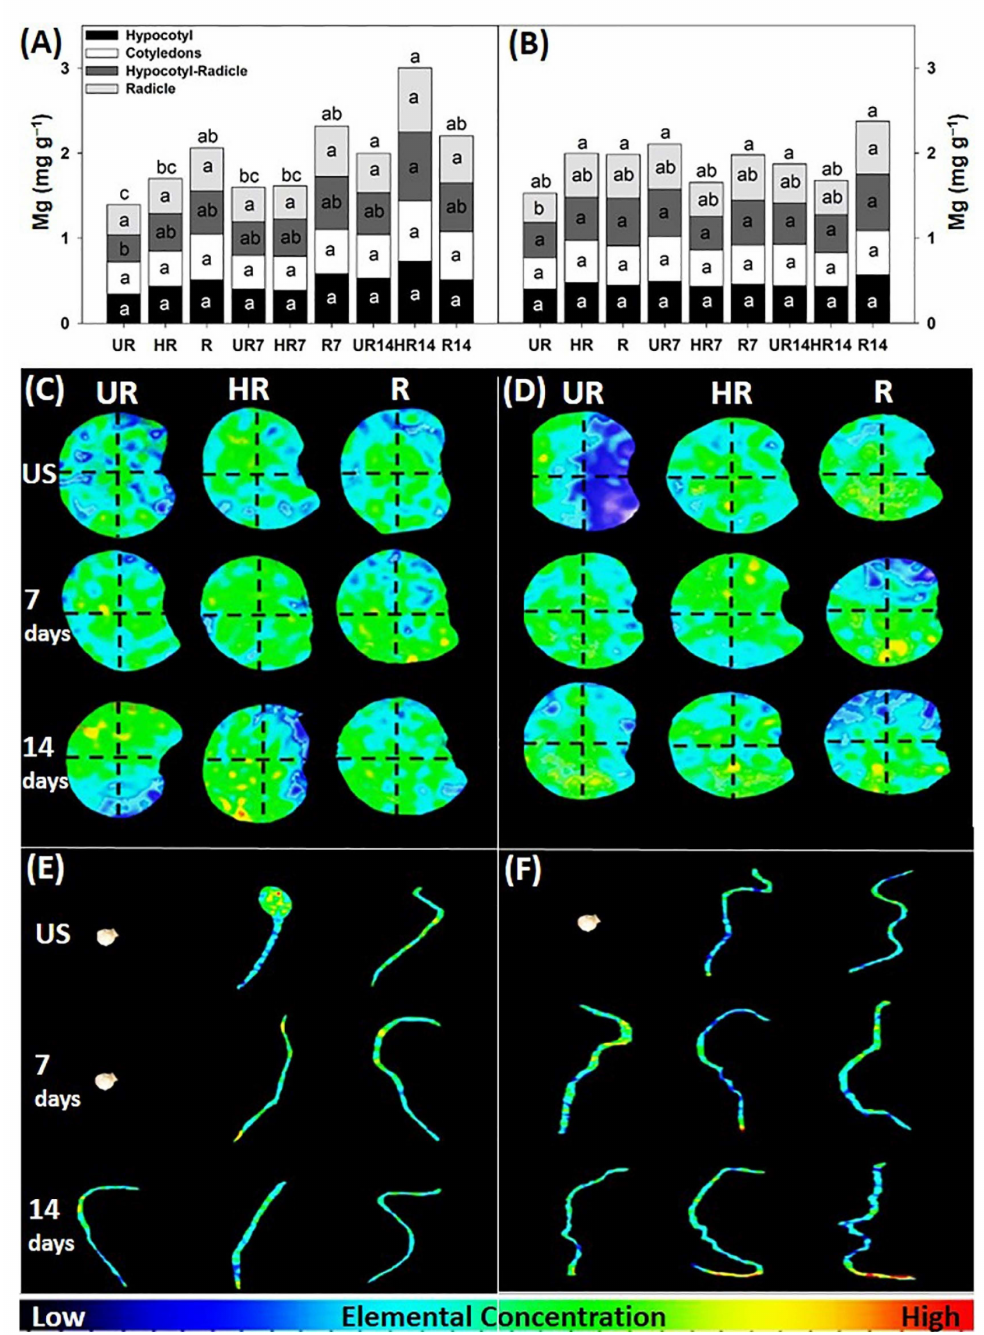
Figure 6. Mg concentration in seeds pre-imbibition ( A ) and post-imbibition ( B ), Mg distribution in habanero pepper seeds pre-imbibition ( C ) and post-imbibition ( D ), habanero seedlings at 10 ( E ) and 14 days ( F ) after sowing, of seeds of unripe (UR), half-ripe (HR), and ripe (R) fruits; unstored (US) and stored for 7 and 14 days postharvest. Colors in panels ( C – F ) are based on a relative intensity scale (reported at the bottom of the figure) generated on the intensity of the X-ray fluorescence K α peak of Mg in the samples. Data are means. Different letters indicate statistically significant differences among treatments (Duncan, p ≤ 0.05, n =